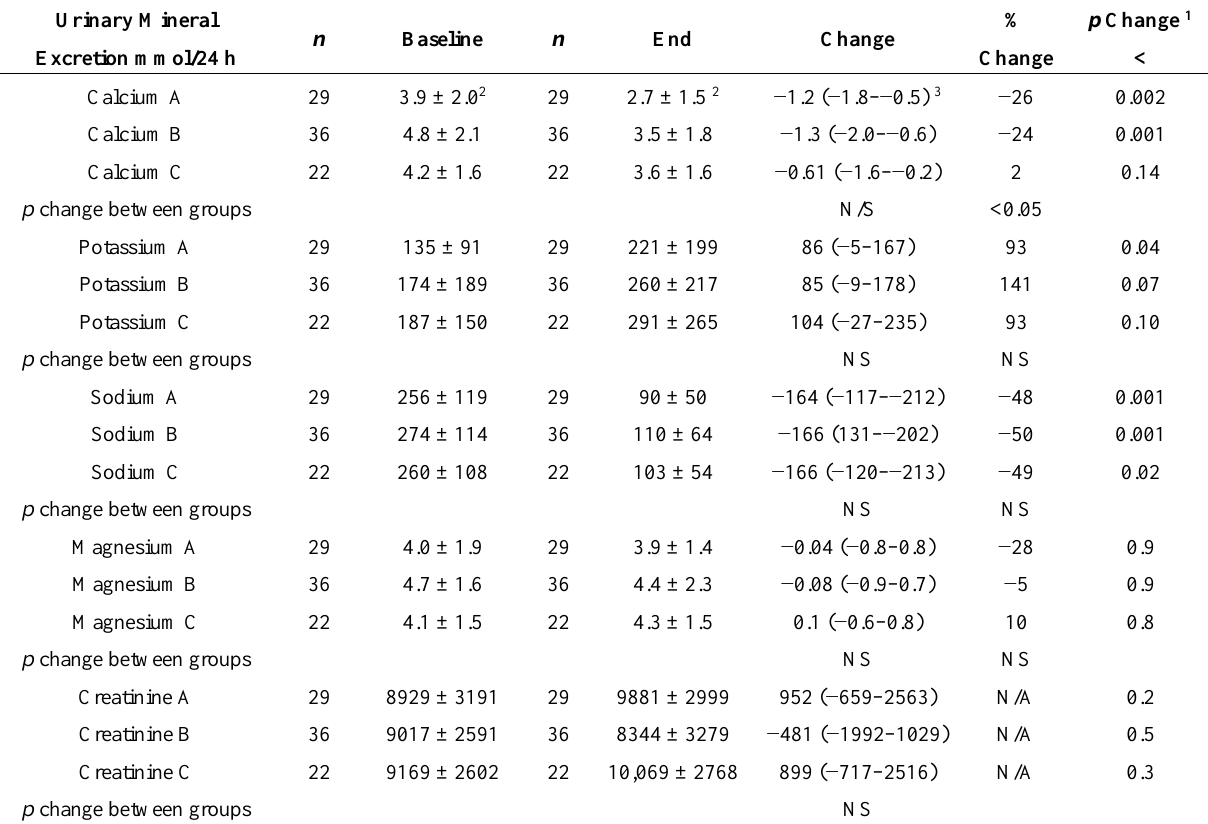
Table 2. Changes in urinary mineral excretion in the three study groups (A, B, C) from